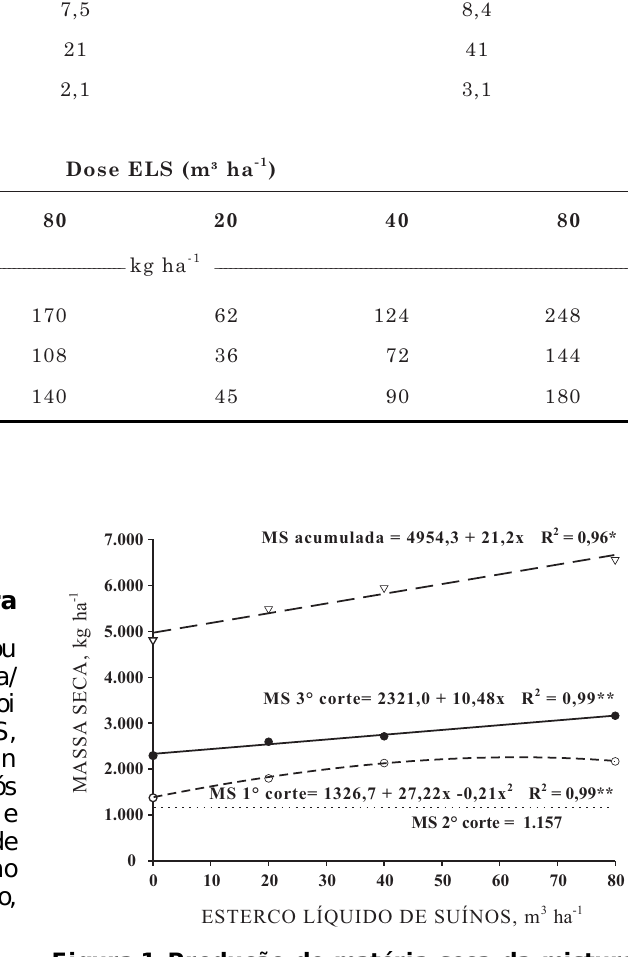
(Figura 1), o que mostra a eficiência da reaplicação. Respostas lineares para produção de matéria seca também foram obtidas por Zebarth et al. (1996) e Almeida (2000), com o uso de doses crescentes de ELS.